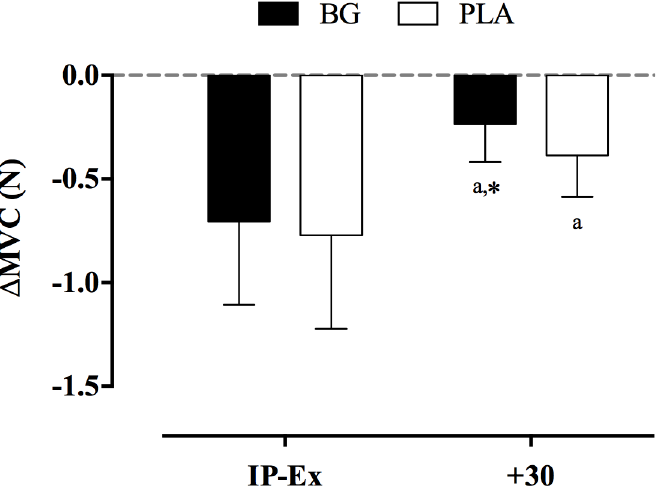
Fig 4. Changes from baseline in maximal voluntary contraction ( Δ MVC, N) of the forearm muscle immediately after exercise(IP-Ex) and 30 minutes of recovery(+30) after beetroot-based nutritional gel (BG) and nitrate-depleted gel (PLA) intervention. The symbol * (P < 0.05) denotessignificantlydifferent from PLA and a significantly different from